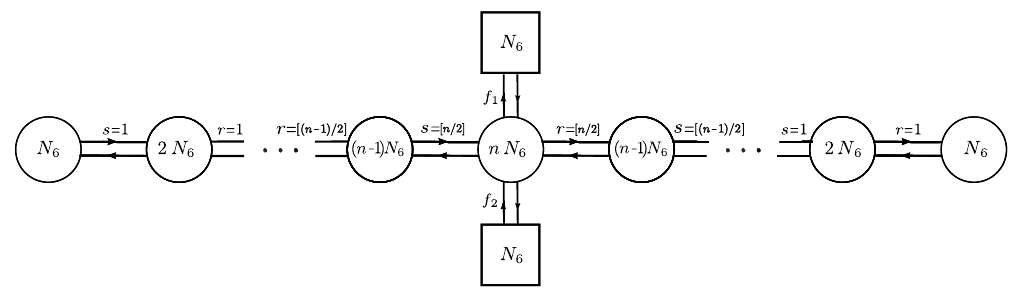
Figure 4 . Linear quiver proposed as dual to the non-Abelian T-dual solution. There are two matter (cid:12)elds Q j ; ~ Q j in the bifundamental and anti-bifundamental of each pair of nodes, associated to a 5-brane connecting adjacent D4-stacks, with a total number of j = 1 ; : : : ; n (cid:0) 1 hypermultiplets H j = ( Q j ; ~ Q j ) at each side of the quiver. We label r = 1 ; : : : ; [ n= 2] the (cid:27) j = +1 hypermultiplets corresponding to NS5-branes and s = 1 ; 2 ; : : : ; [ n= 2] the (cid:27) j = (cid:0) 1 hypermultiplets from NS5’-branes, assuming an alternating distribution of both types of 5-branes. This con(cid:12)guration comes from a re-ordering of the branes in (cid:12)gure 1 that is consistent with Seiberg self-duality and the vanishing of the beta functions and R-symmetry anomalies. The squares in the middle of the quiver denote (cid:13)avor groups corresponding either to semi-in(cid:12)nite D4-branes ending on the NS5 and NS5’ branes or to D6-branes transversal to the D4-branes. They complete the quiver at (cid:12)nite n . We choose (cid:27) f = (cid:0) (cid:27) f for the corresponding fundamental 1 2